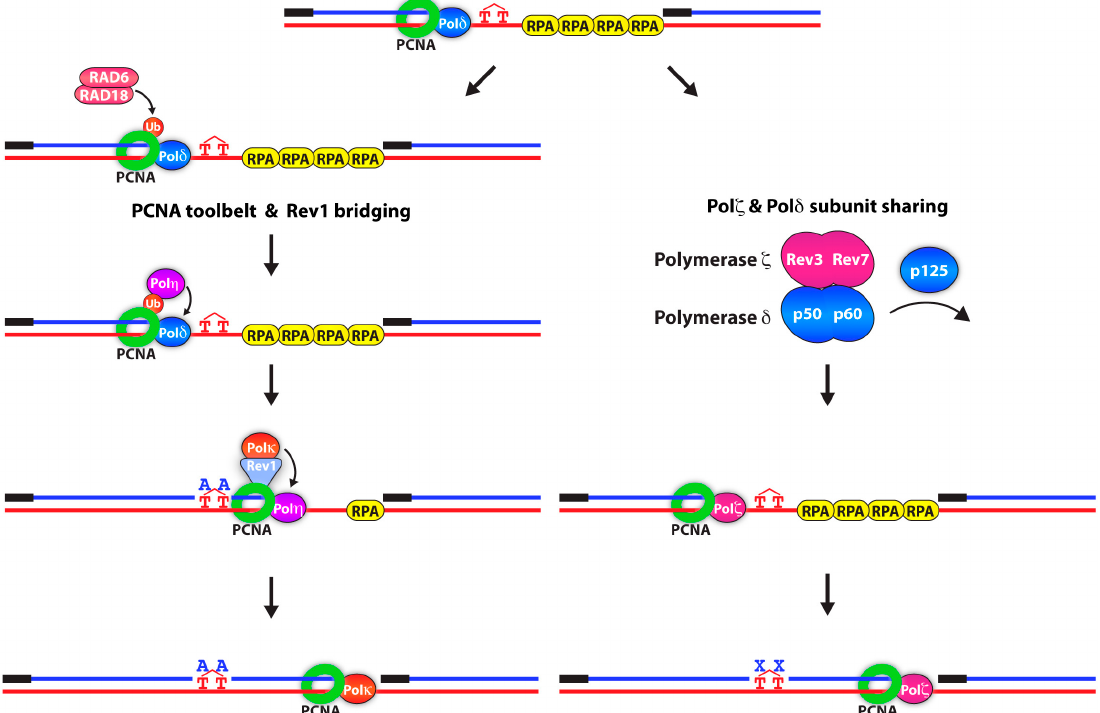
Figure 1. Two models for polymerase switching during translesion synthesis. In the PCNA toolbelt and Rev1 model, mono-ubiquitinated PCNA recruits the TLS polymerase, Pol η via its UBZ domain and replaces Pol δ for the insertion step. Following the insertion step across the lesion, Rev1 binds PCNA through its BRCT/PAD domain. Rev1 functions as a “bridge” to recruit Pol κ for the extension step. Pol κ replaces Pol η and extends the mismatched nascent DNA. In the Pol ζ and Pol δ subunit sharing model, upon Pol δ stalling, the catalytic subunit of Pol δ , p125, dissociates and is replaced by Rev3-Rev7 subunits of Pol ζ . This subunit sharing facilitates the switch from Pol δ to Pol ζ , thus bypassing the DNA lesion. X represents any nucleotide. If the lesion is replicated by Pol η , X is likely an “A”. However, other TLS polymerases such as Pol ζ can incorporate mismatched nucleotides. Abbreviations: polymerase-associated domain.